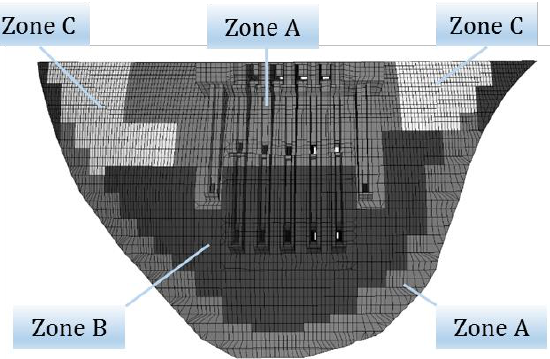
Figure 14. The finite element model of zoning concrete of dam body.